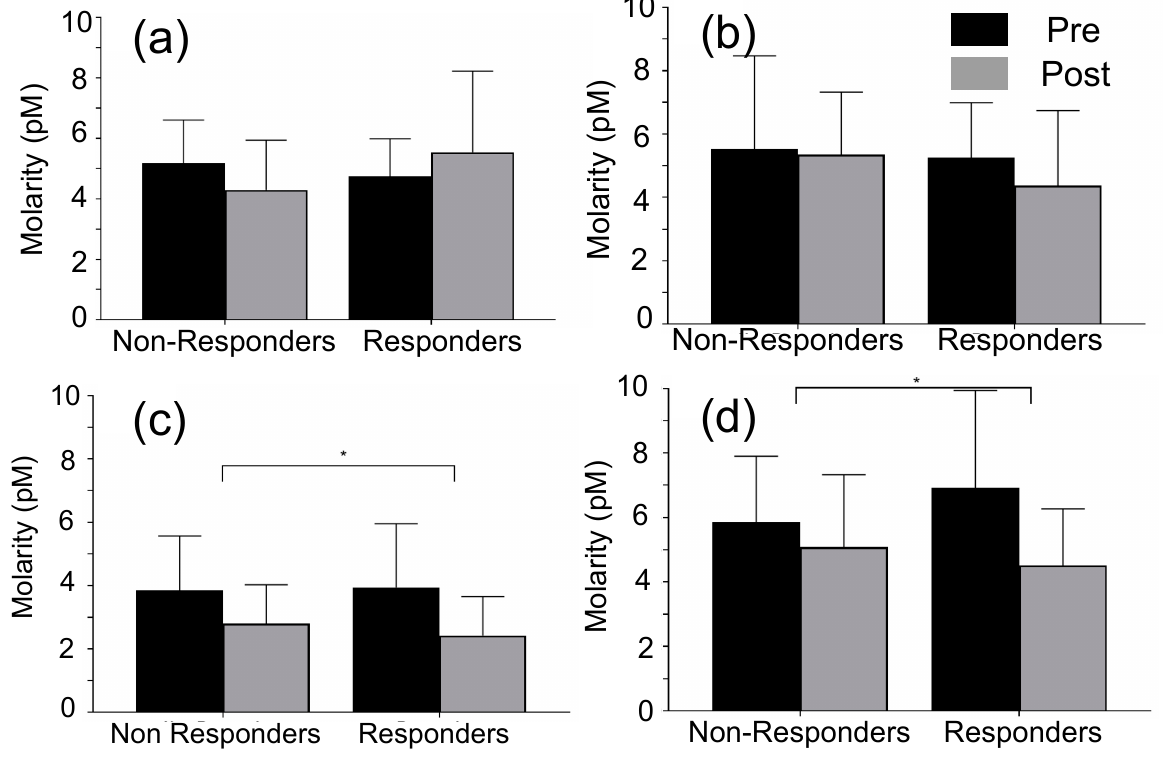
molarities yielded R-squared values of 84.8% and 78.8% for the fat mass and lean mass regressions, respectively. Thus, the miR covariates uniquely and jointly (and over and above the effects of the other model covariates) predicted 6.9% and 8.8% of the variation in fat mass and lean mass, respectively. The F-statistic indicates that this difference is significant for the fat mass regression ( p < 0.05) but not significant for the lean mass regression ( p = 0.055). At the level of the individual coefficients—and holding constant the effects of the other model covariates—miRs-140 and -935 significantly predicted fat loss (all p values < 0.05) (Table 3).